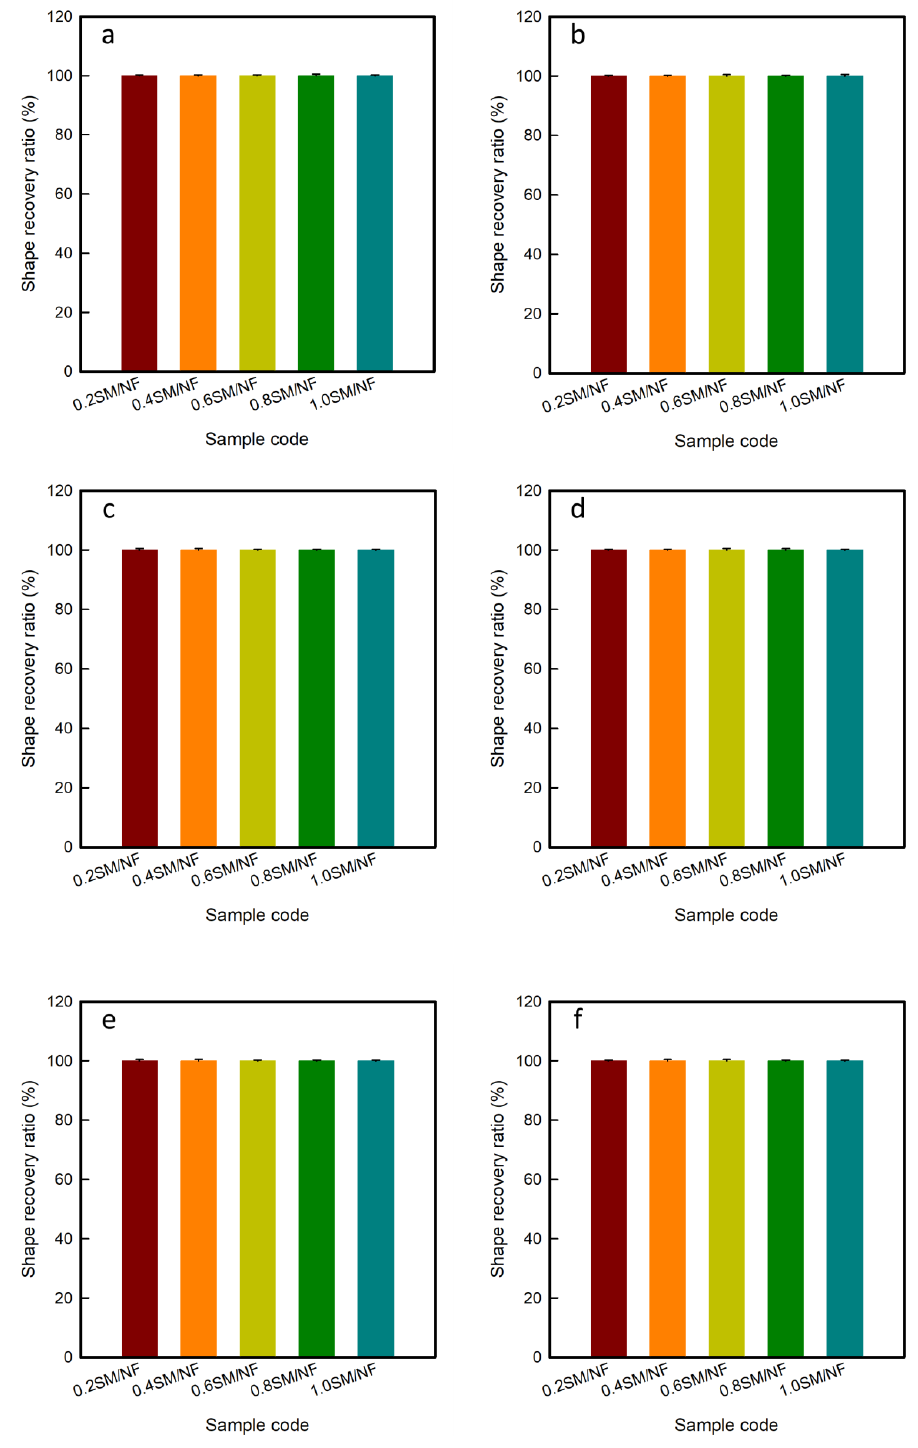
Figure 3. Shape recovery ratio of 3D-printed sinusoidal sample/nylon composite with various thicknesses during ( a ) 1st cycle, ( b ) 10th cycle, ( c ) 20th cycle, ( d ) 30th cycle, ( e ) 40th cycle, and ( f ) 50th cycle.